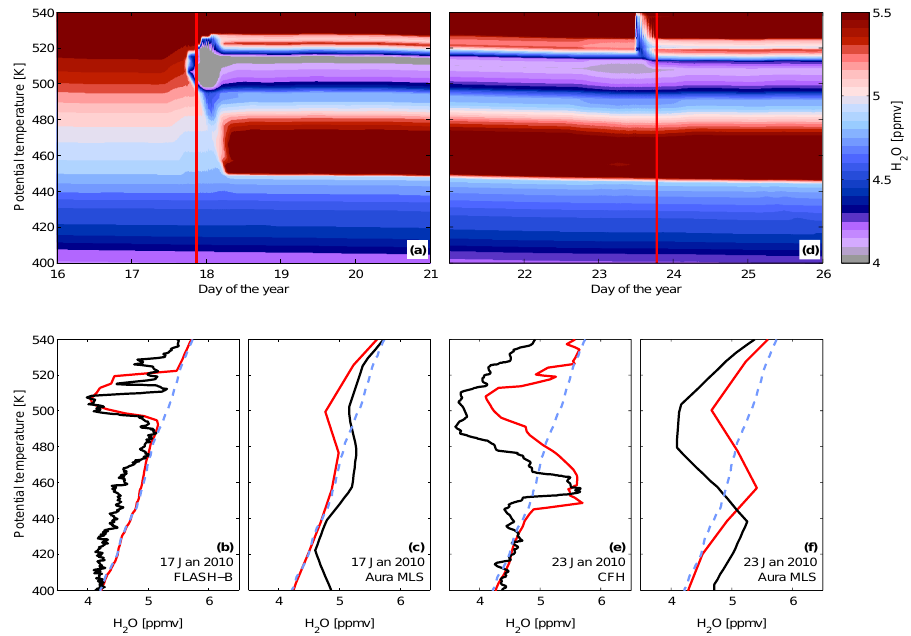
Fig. 4. Results from the microphysical column model ZOMM driven by ERA-Interim based CLaMS trajectories with superimposed small- scale temperature fluctuations. Upper panels (a, d) : time series of water vapor mixing ratios (color coded); vertical red lines: S1 and S2. Lower panels: comparison between simulations (red) and measurements (black), namely FLASH-B (b) , CFH (e) and MLS (c, f) . Simulations (red lines) in (c) and (f) have been smoothed and interpolated corresponding to the vertical resolution of the instrument. Blue dashed line in lower panels (b, c, e, f) : climatological mean water vapor profile. MLS data are interpolated to orbits 2010-01-18T00-19-57Z (c) and 2010-01-24T01-22-07Z (f) closest to